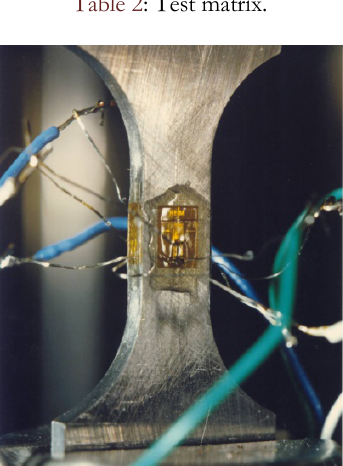
Table 2: Test matrix.